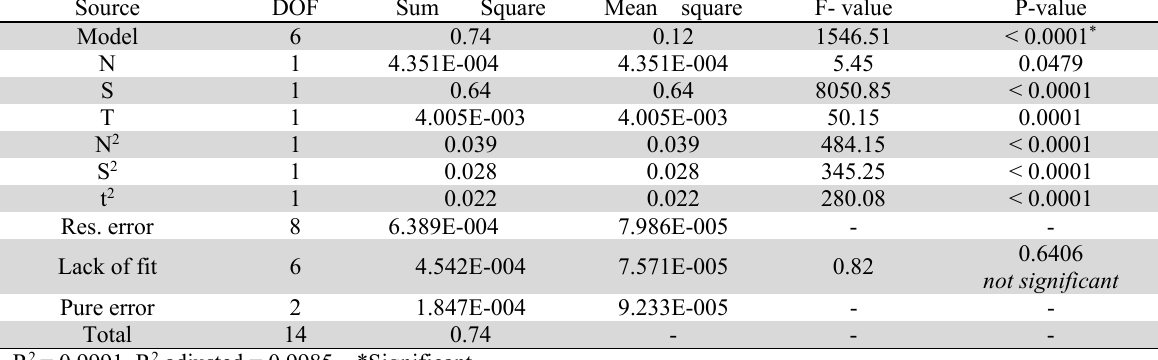
ANOVA table for surface roughness (after backward elimination)